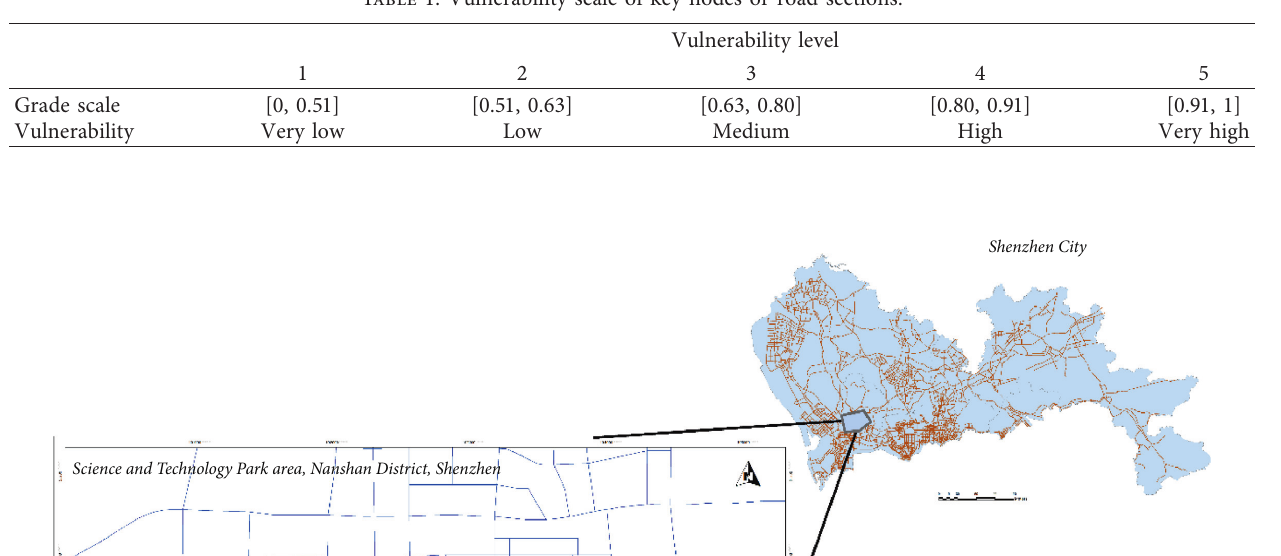
Table 1: Vulnerability scale of key nodes or road sections.